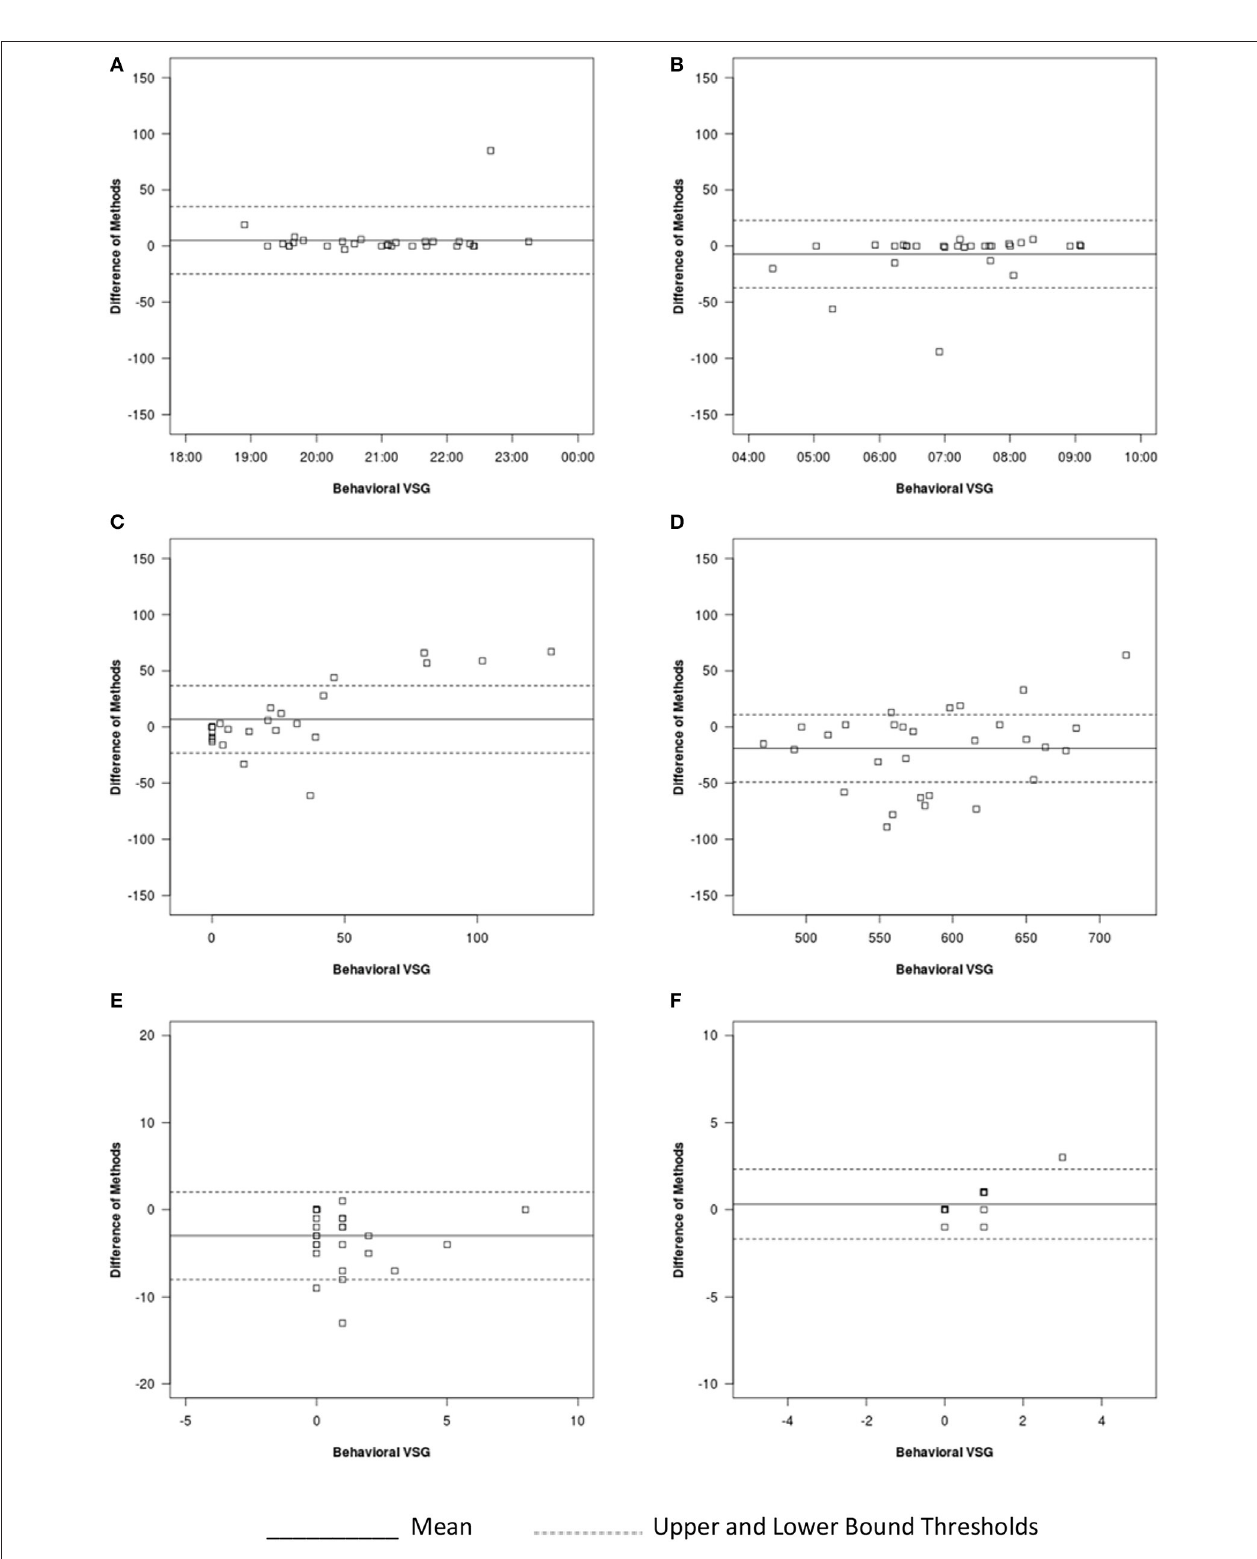
FIGURE 3 | Bland-Altman plots for auto-VSG and behavioral VSG coding for (A) sleep onset, (B) sleep offset, (C) WASO, (D) sleep duration, (E) number of minor wakings, and (F) number of major wakings.